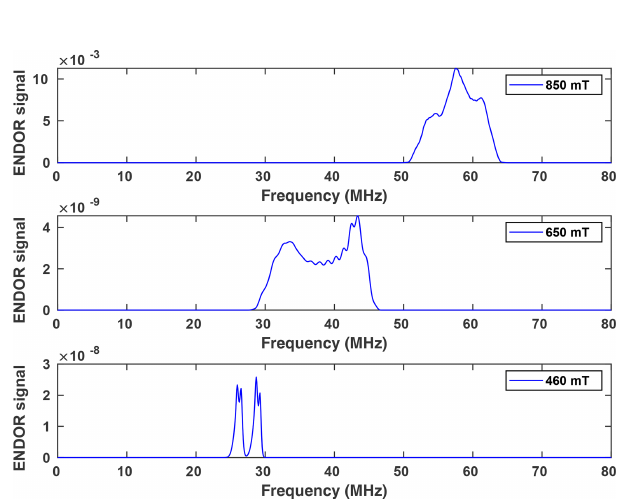
Figure 7. Simulated ENDOR spectra of NO@C60-OH1, using pa- rameters listed in Table